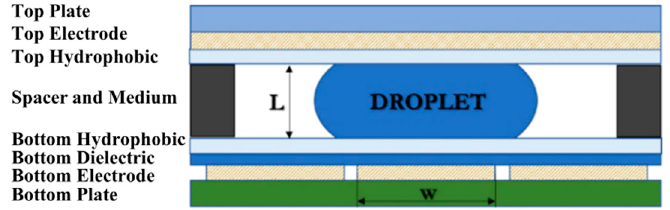
Figure 1. Configuration of a closed-typed EWOD device.